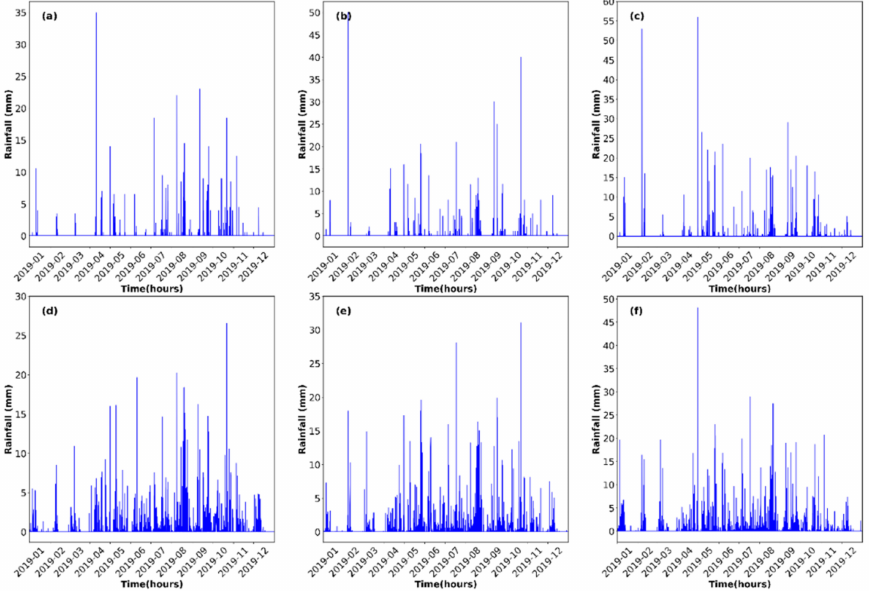
Figure 4. Observed ( a – c ) and reconstructed ( d – f) time series of hourly rainfall for three representative KSNDMC stations (station numbers: 2306, 2309, and 2318) for the year